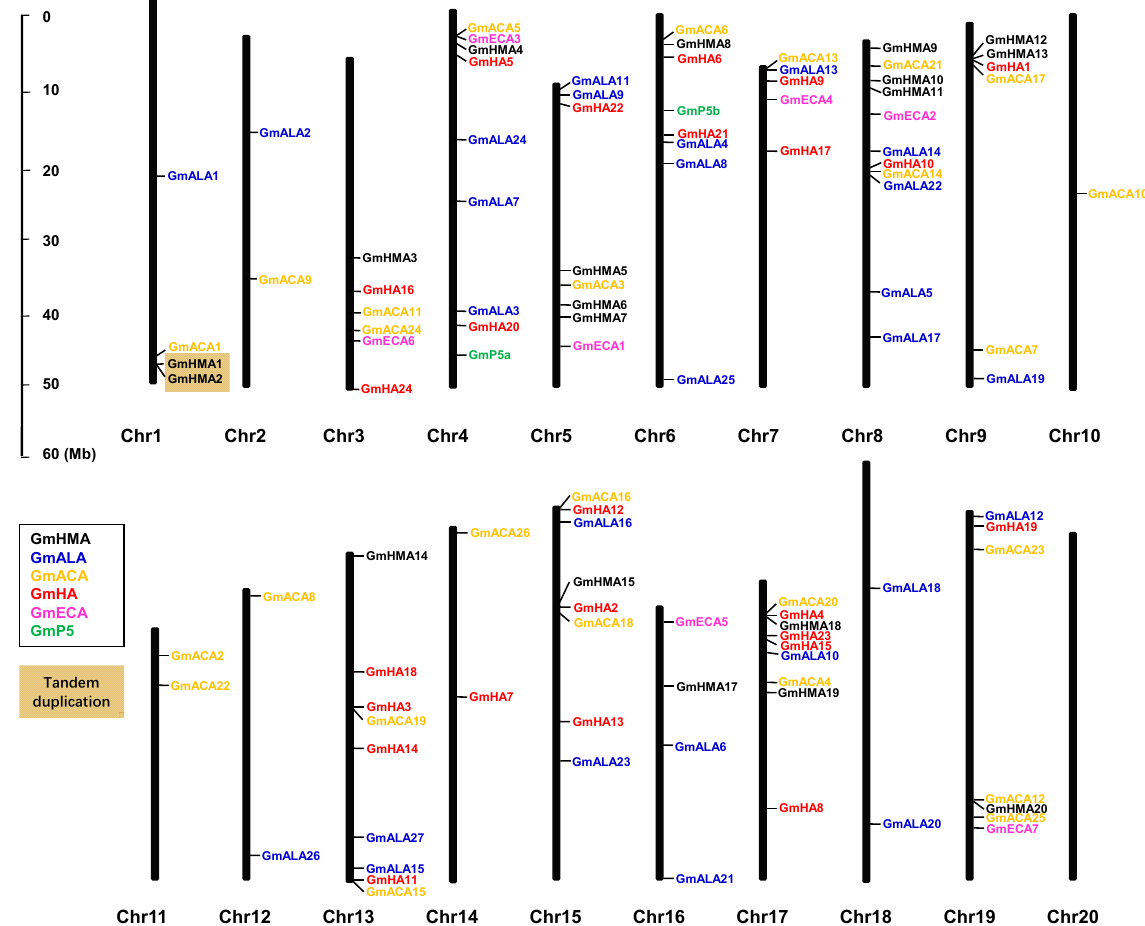
Figure 10. Graphical representation of locations for all the P-type ATPase genes on each chromosome of soybean: genes belonging to the same family are shown in the same color. Genes within a light golden box are putatively tandemly du- plicated.